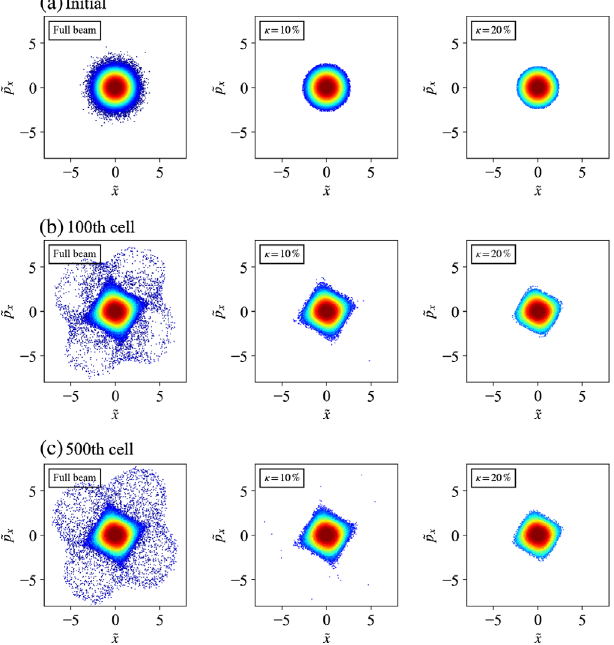
FIG. 4. Phase-space configurations at ν 0 ¼ 0 . 257 with three different tail-truncation factors ( κ ¼ 0 , 10, 20), observed at (a) the transport entrance, (b) 100th FD cell, and (c) 500th FD cell.